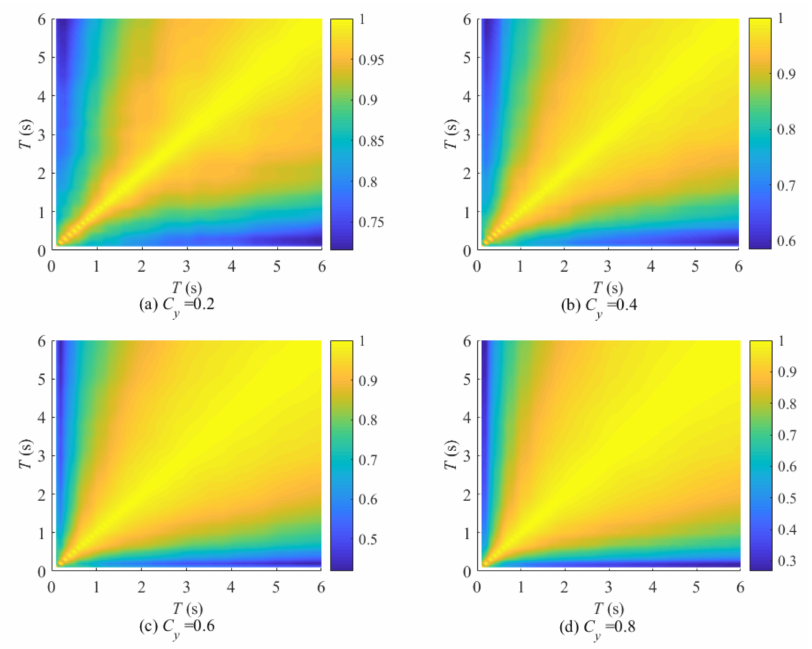
Figure 6. Correlation analysis of S d rankings at different periodic points (Bilinear model).